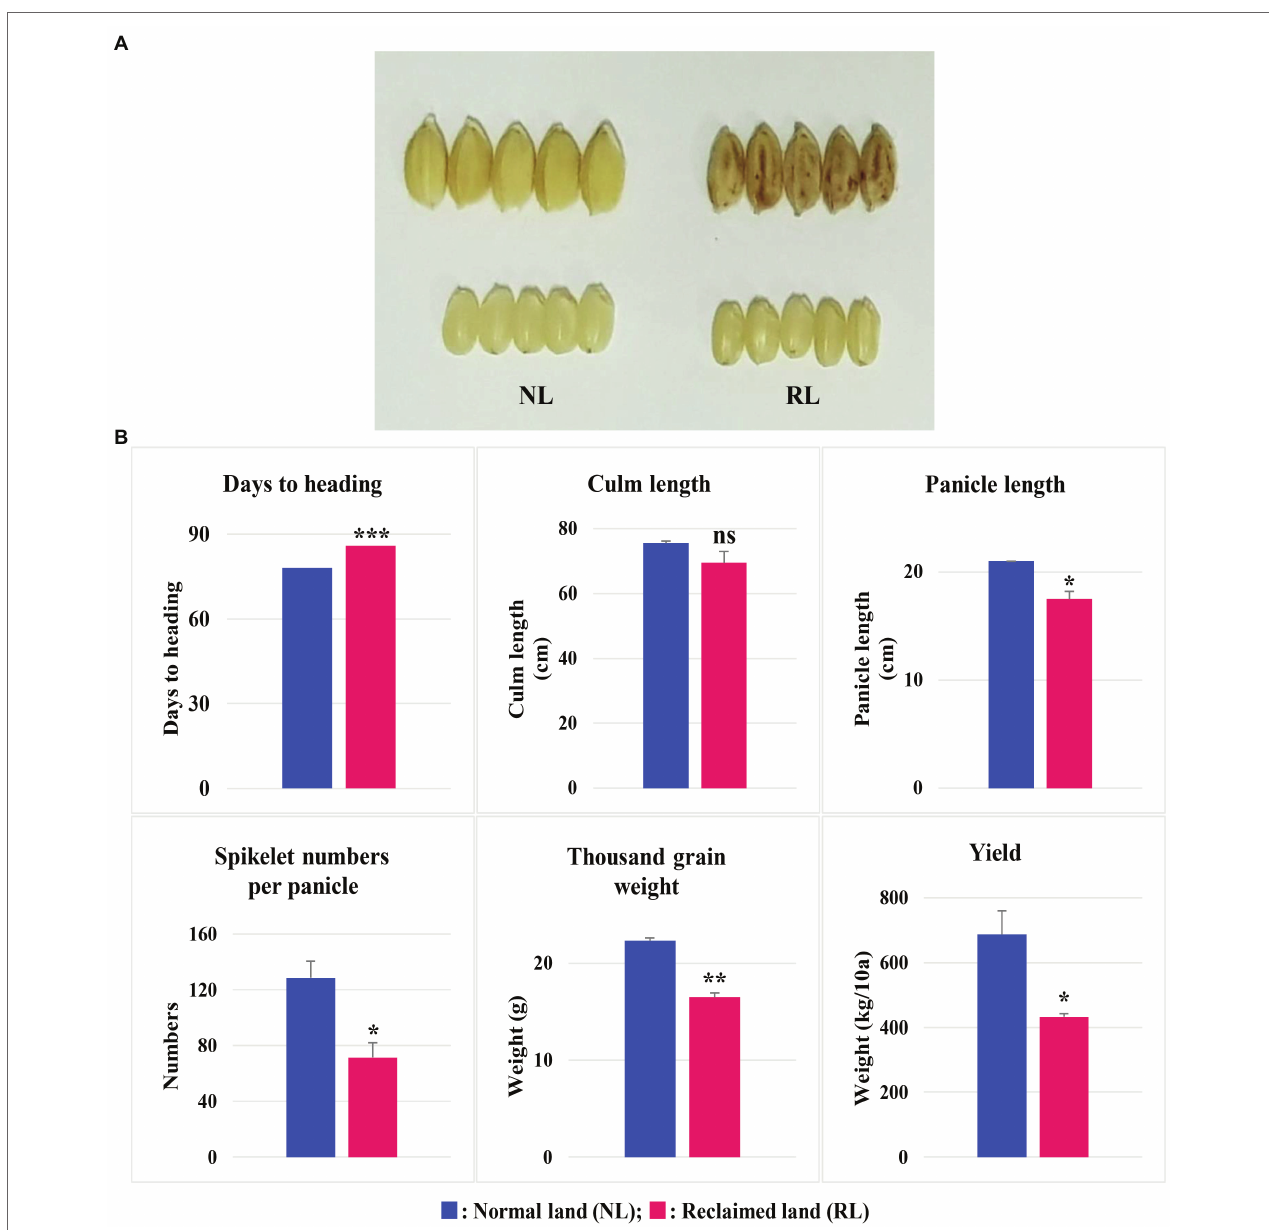
FIGURE 1 | Agronomic traits of Samgwang grown on normal land (NL) and reclaimed land (RL) in 2018. (A) Rice seeds harvested on NL and RL. (B) Agronomic traits, including days until heading, culm length, panicle length, spikelet numbers per panicle, thousand grain weight, and yield. Data represent mean ± SD. ns: not significant; *0.01 < p < 0.05; **0.001 < p < 0.01; *** p < 0.001. Significant difference for each dataset was determined by t -test.